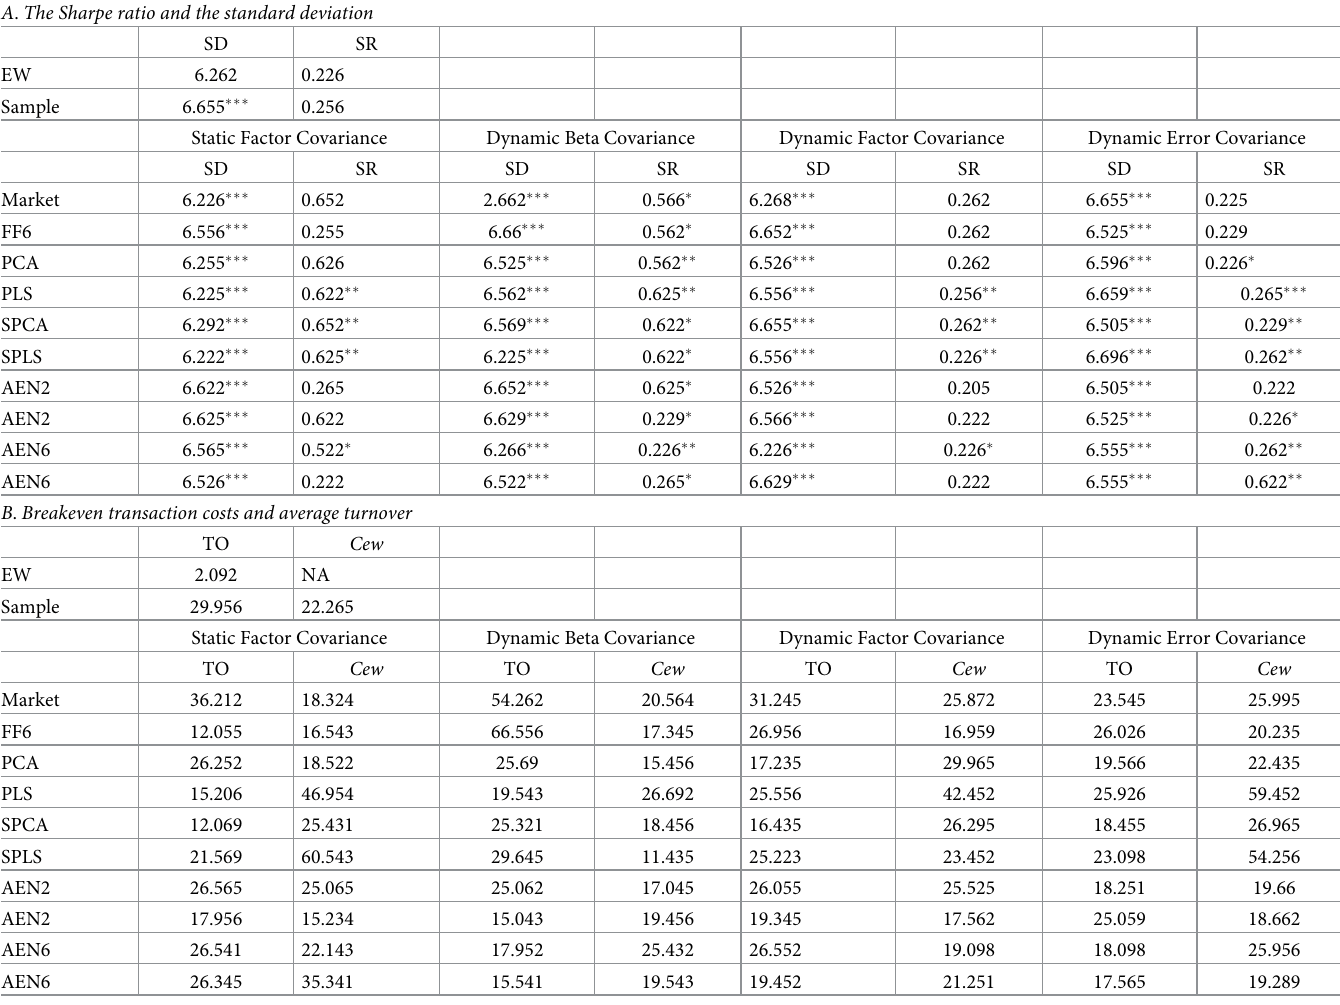
Table 6. Track portfolio performance using a penalized minimum-variance target function. A . The Sharpe ratio and the standard